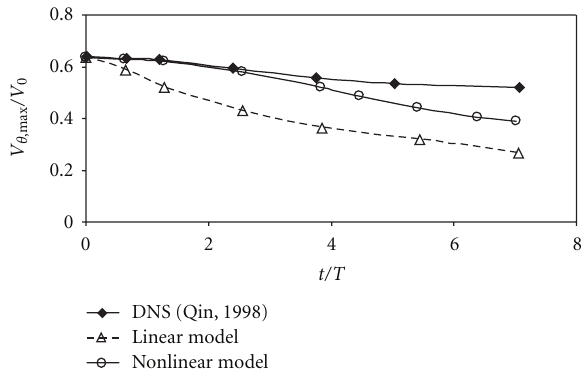
Figure 3: Comparison of temporal decay of maximum tangential velocity calculated by RANS with Qin’s DNS